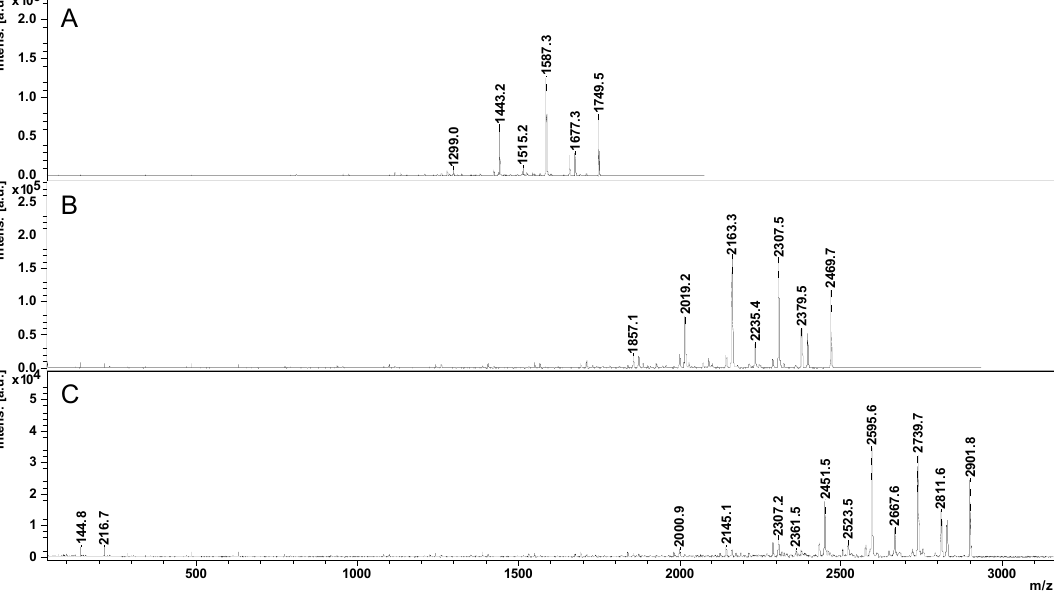
Figure 5. Comparative view of the MS/MS spectra of the CD-LA, K-charged parent ions: [CD-LA 4 + K] + ( A ), [CD-LA 9 + K] + ( B ), and [CD-LA 12 + K] + ( C ). the ROP process of LA . This fact supports the lower propensity of transesterifications for the ROP reaction system leading to the formation of the CD-LA